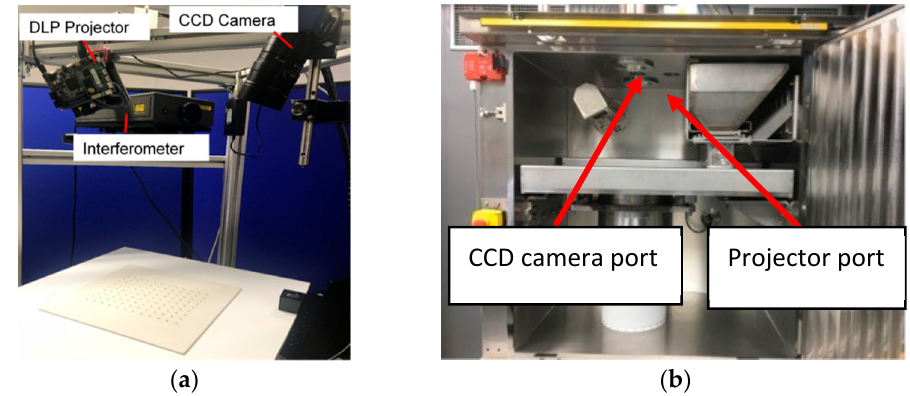
Figure 11. Experimental setup and AM machine: ( a ) proof-of-concept experimental system; and ( b ) EBM machine.